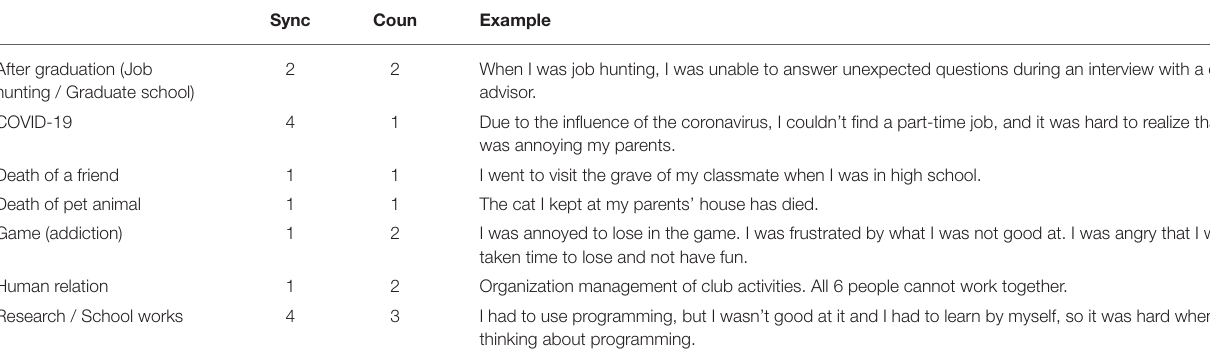
TABLE 3 | Classification of the written texts in the mood induction task. Sync Coun